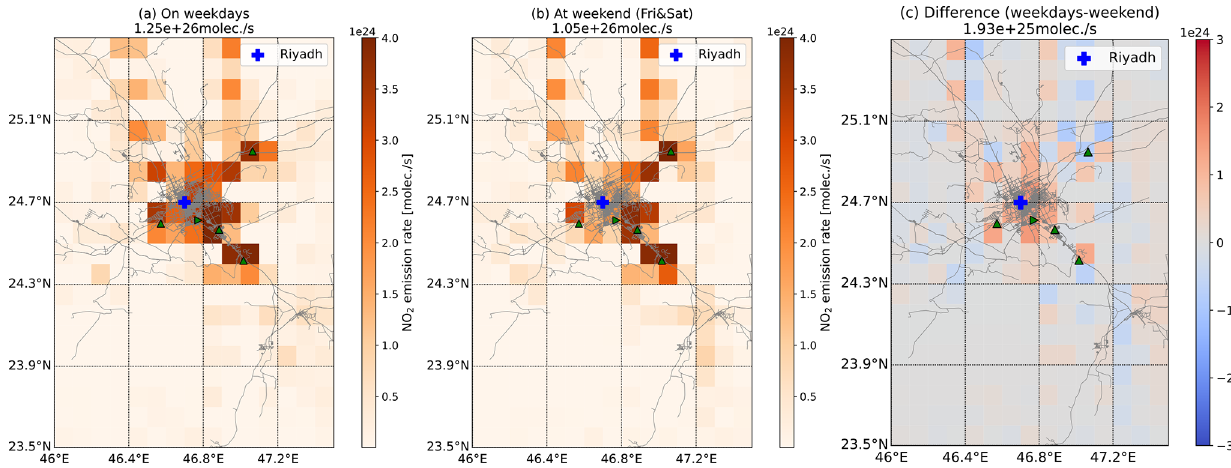
Figure 3. Averaged ML-estimated emission strengths for (a) weekdays (Sunday to Thursday), (b) weekends (Friday and Saturday), and (c) their difference (weekdays − weekend) in Riyadh. The number in each panel heading presents the total emission rate.